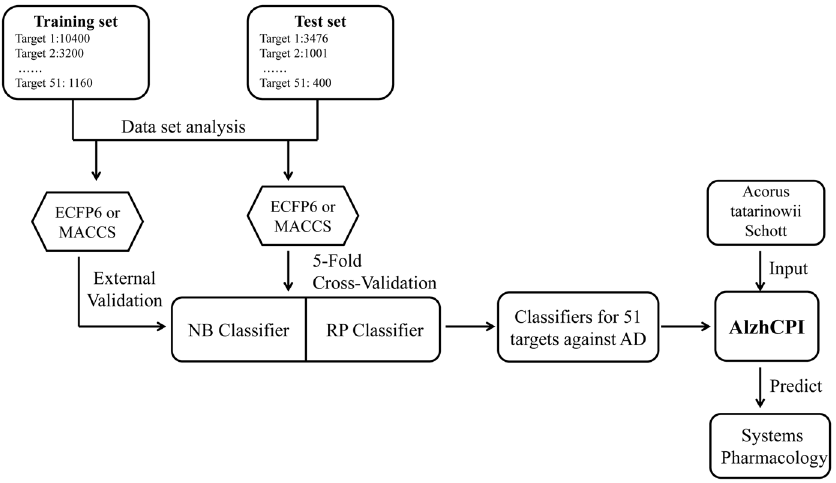
Fig 1. The schematic workflow of AlzhCPI to predict cheimical-protein interactions toward Alzheimer’s disease based on the multitarget quantitative structure-activity relationships (mt-QSAR).